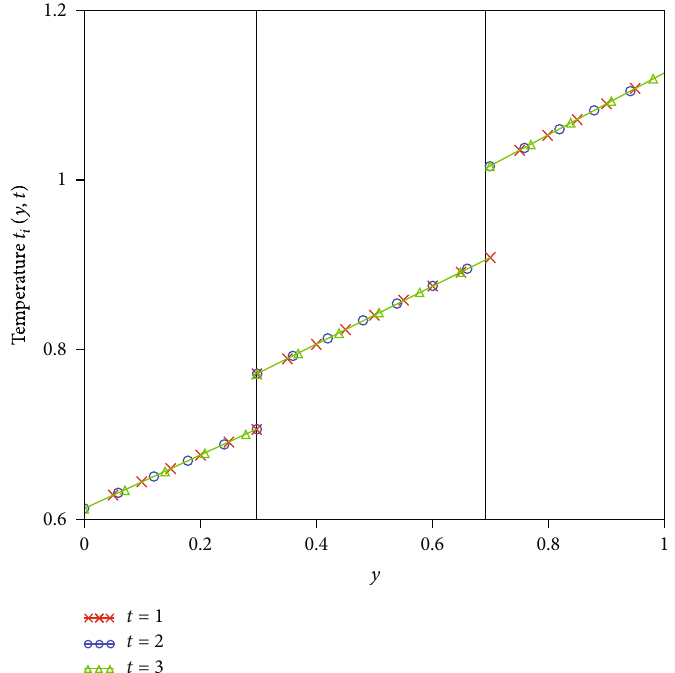
Figure 7: Temperature pro fi les T